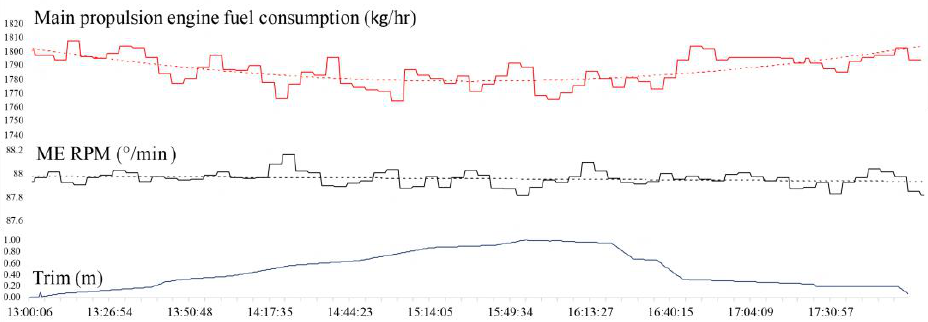
Figure 3. Main propulsion engine fuel oil consumption (FOC) change with change of trim. The RF regression prediction algorithm built the model in 7.00 s with a C C of 0.9992,